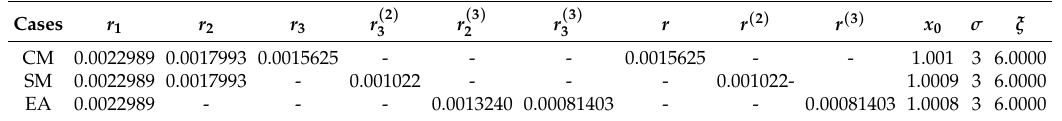
Table 1. Radii for Example